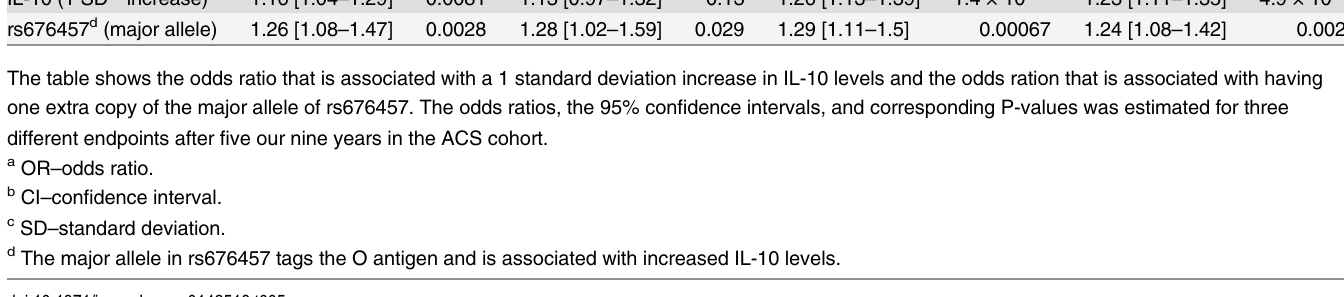
Table 5. Odds ratio for disease outcome in ACS patients with different IL-10 levels or ABO alleles. Marker Myocardial infarction Cardiovascular death Any cause of death after 9 after 5 years after 5 years years OR [95% CI]